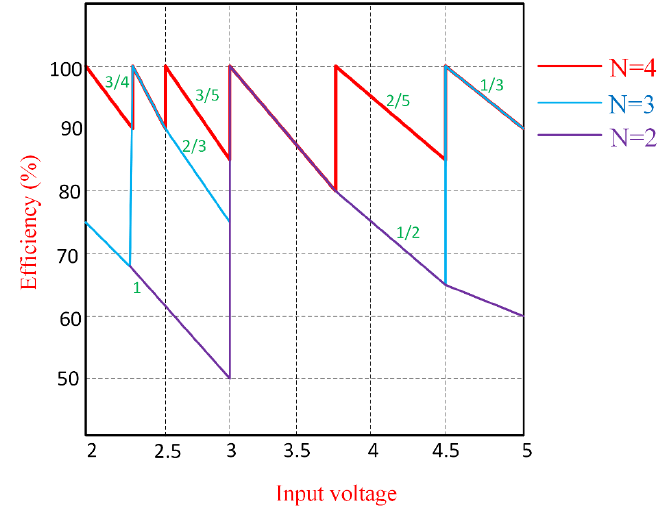
Figure 3. Comparison of a multiratio switched-capacitor converter’s theoretical efficiency (without including switching losses), with N = 2, 3, 4. ‘N’ represents the number of capacitors together with the output capacitor Cout [25]. Reproduced from [25], IEEE TRANSACTIONS ON POWER ELEC- TRONICS:2013.